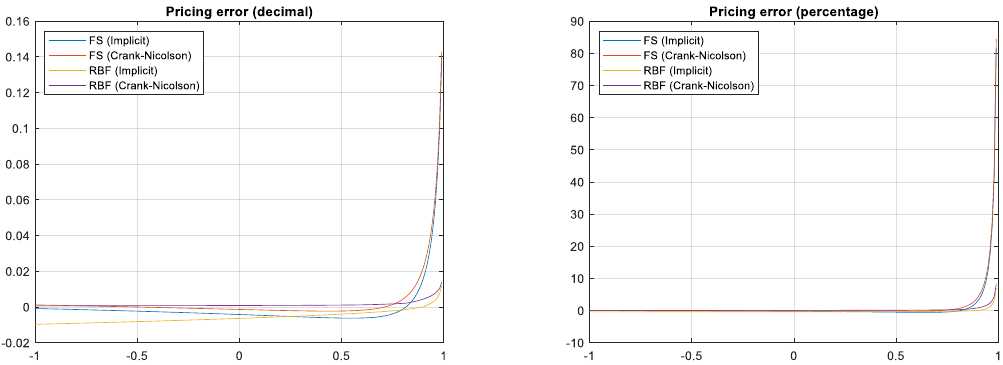
Figure 5. Decimal ( Left ) and percentage ( Right ) pricing errors of the fractional step method (FS) and the radial basis functions (RBF) with respect to the correlation.